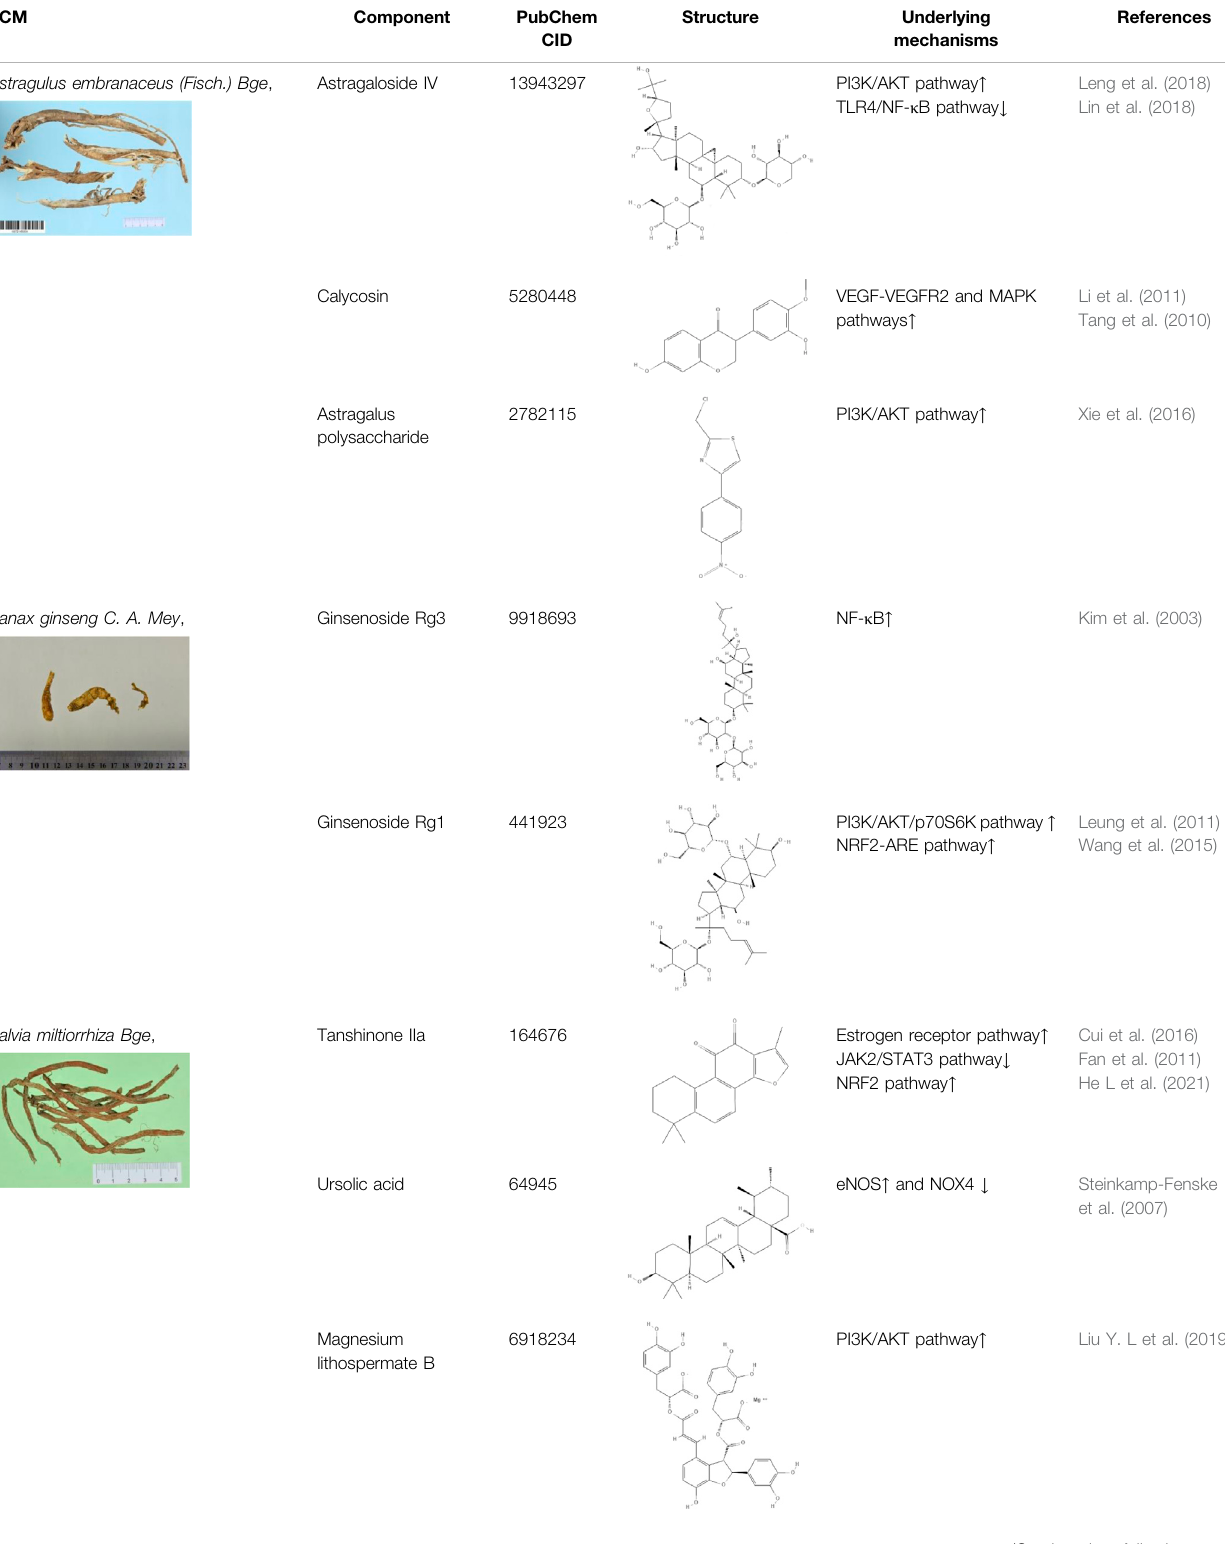
TABLE 2 | The mechanisms of TCM in improving